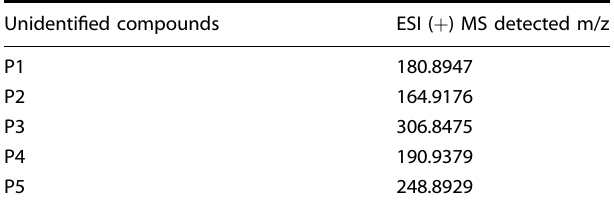
Table 4. Unidenti fi ed compounds detected by LC-MS during CBZ degradation by combined system